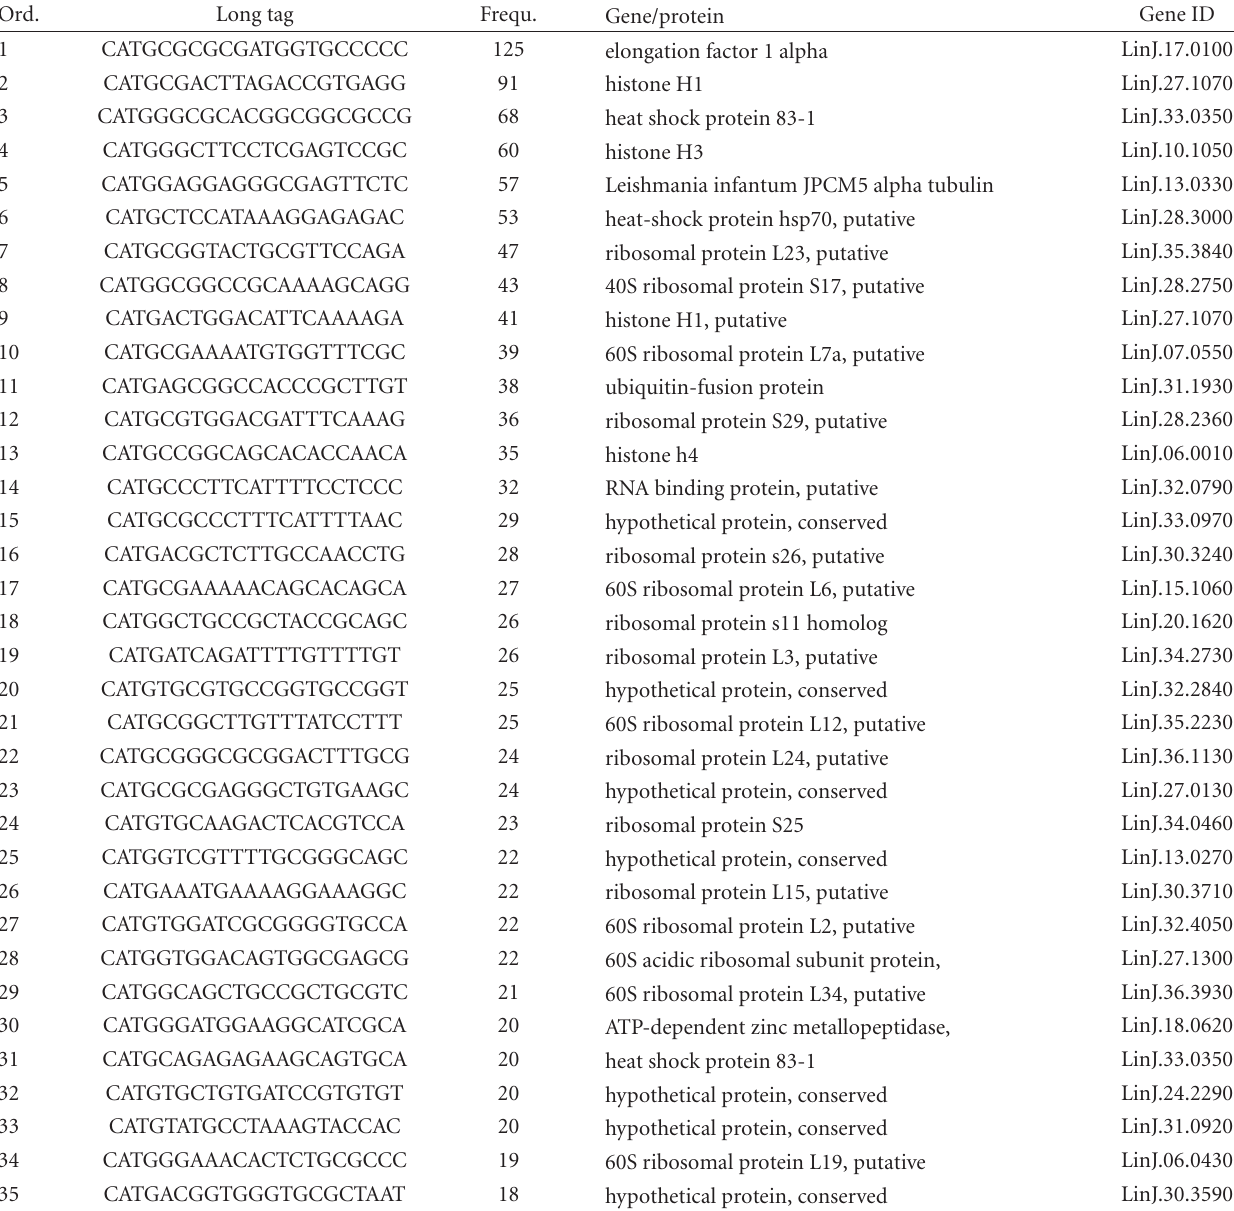
Table 4: Most abundant and annotated transcript and corresponding tags identified in the library of L. i. chagasi promastigotes.